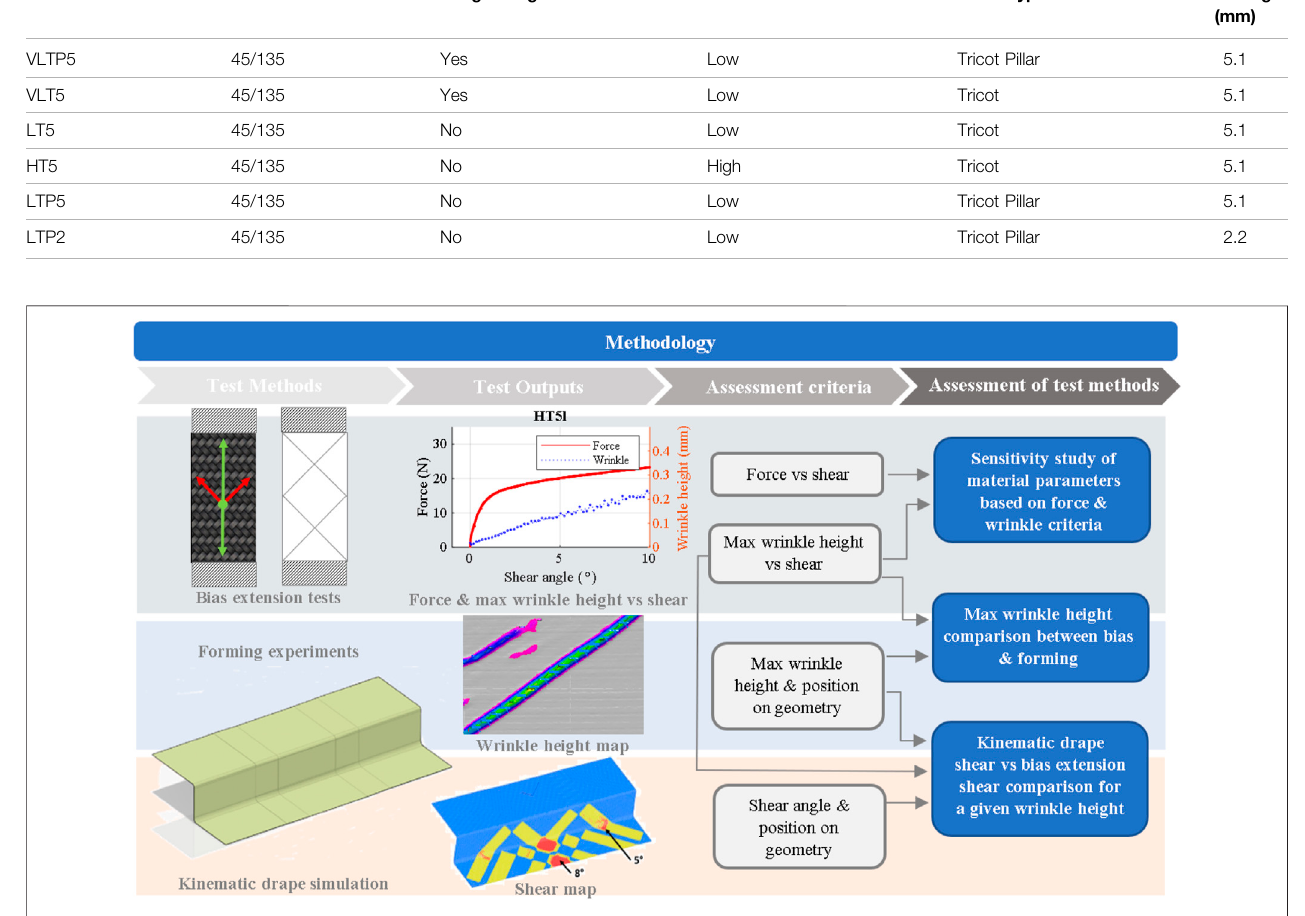
FIGURE 3 | Summary schematic of methodology